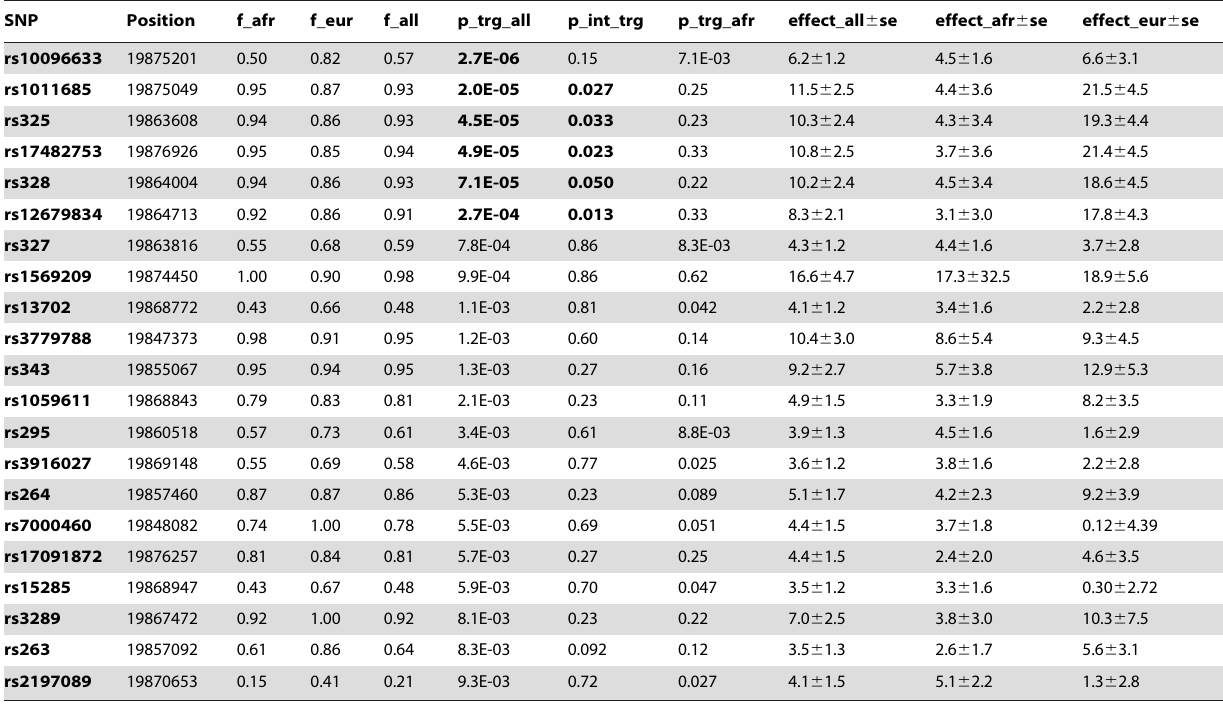
Table 4. Effect size of LPL variants on TG